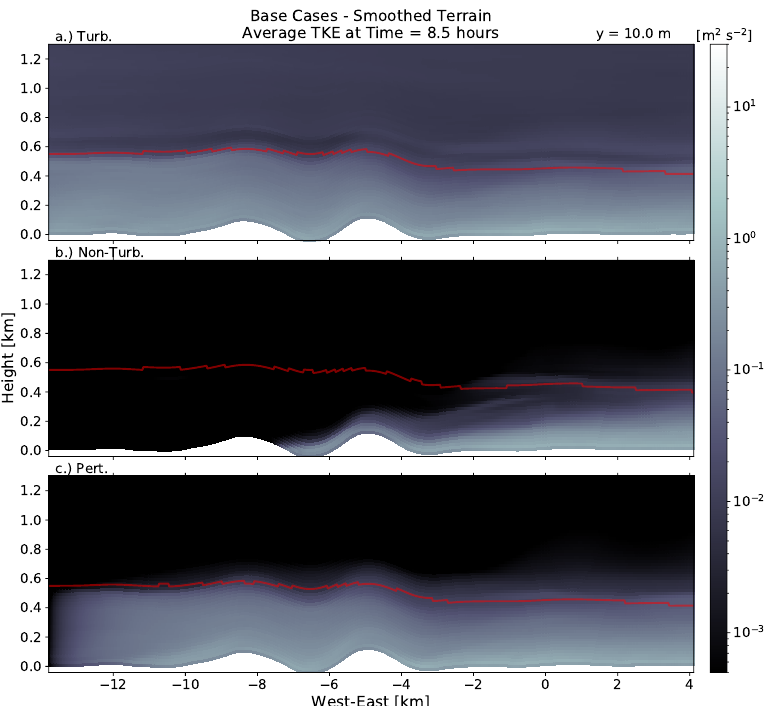
Figure 14. Same as in Figure 8 but for time-averaged TKE for simulations over smoothed terrain for the ( a ) Turbulent, ( b ) non-turbulent, and ( c ) cell perturbation